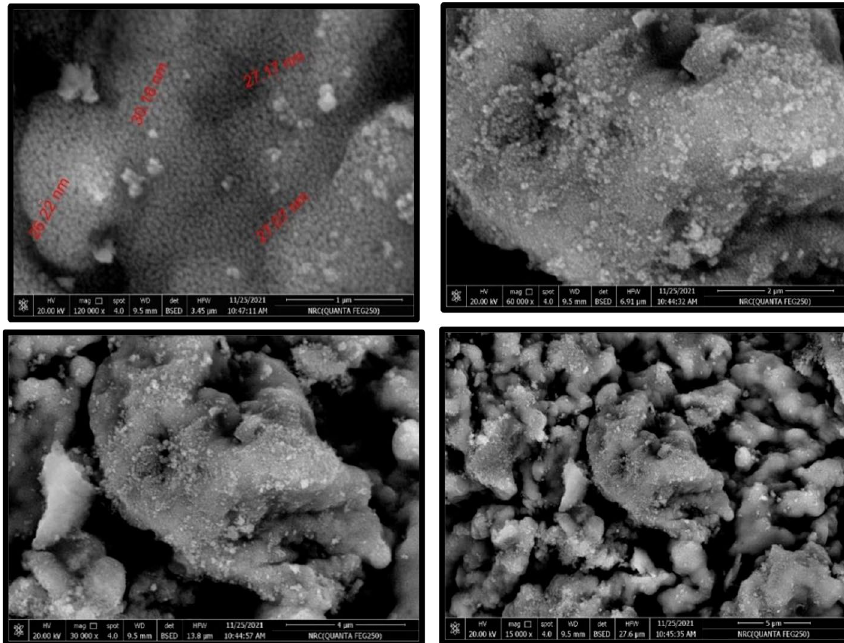
Figure 7. Scanning electron microscopy (SEM) images of CoZnAl2O4 catalysts.